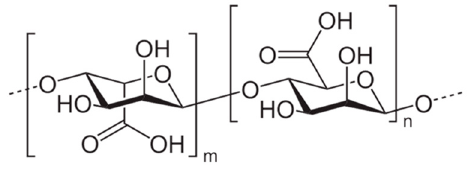
Figure 3. Structure of alginate.